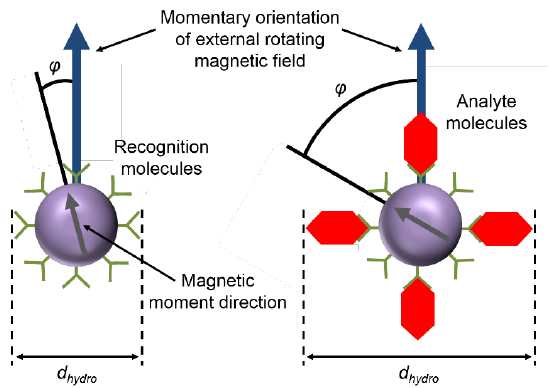
Figure 6. Schematic illustration of the phase lag ϕ as measurement signal for magnetic particle labels with dominating Brownian relaxation behavior excited by a rotating magnetic field. The magnetic moments of the particle labels lag behind the applied rotating magnetic field by a phase lag ϕ , which depends on the hydrodynamic NP diameter d hydro . A change in d hydro upon analyte molecule binding causes an increase of the measured phase